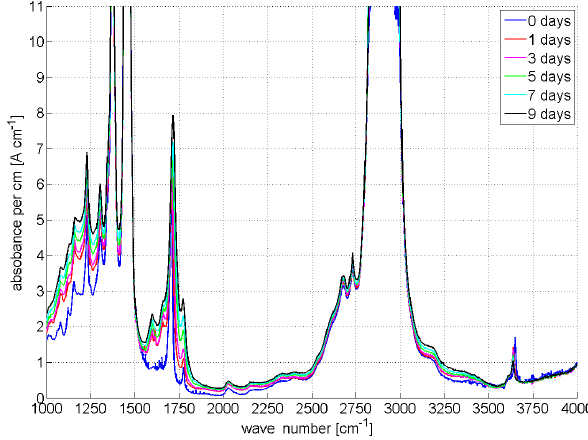
Figure 3. IR spectra of synthetic motor oil from a gas engine (com- bined heating and power unit) at different stages of aging under normal operating conditions.